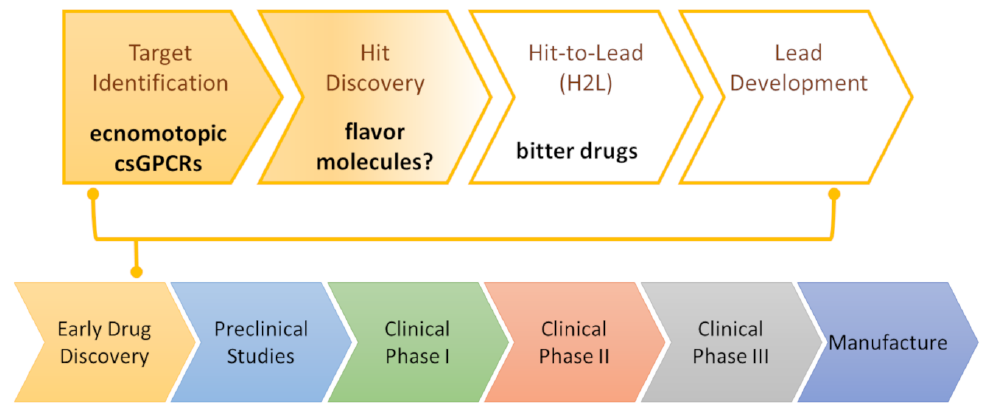
Figure 3. Drug discovery pipeline for csGPCRs.